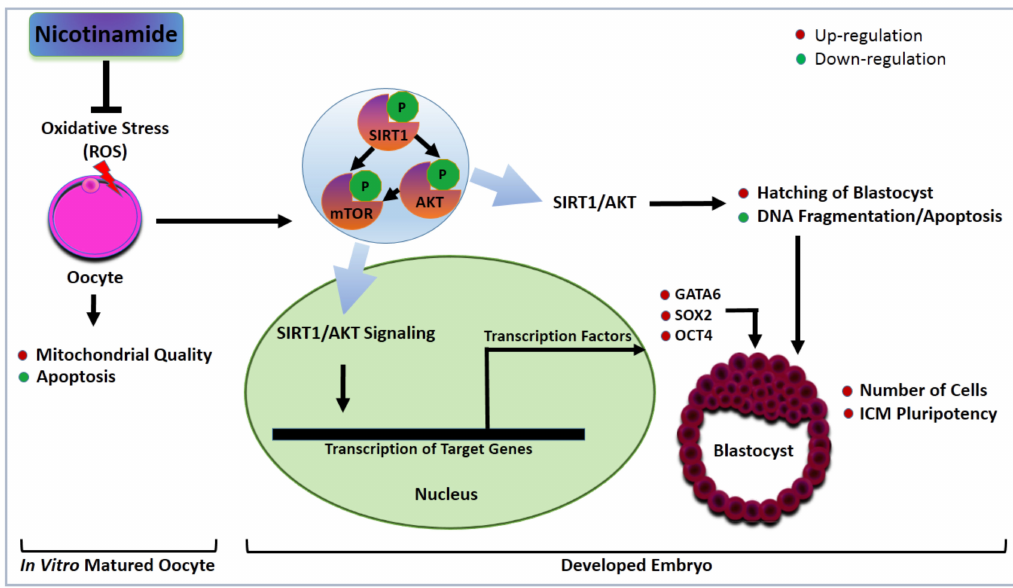
Figure9. Proposedmechanismforthee ff ectofNAMsupplementationduringIVMonthedevelopmental competence of bovine embryos. Low NAM concentrations can reduce oxidative stress and apoptosis and improve mitochondrial function in oocytes. The high quality and hatching rate of embryos developed from NAM-treated oocytes could be accredited to the regulation of SIRT1 / AKT signaling,